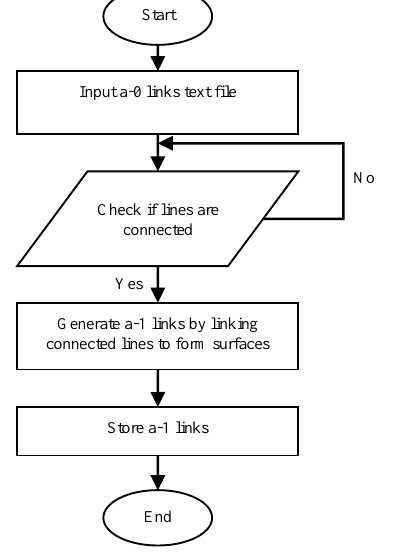
Figure 9. Flowchart for generating a-3